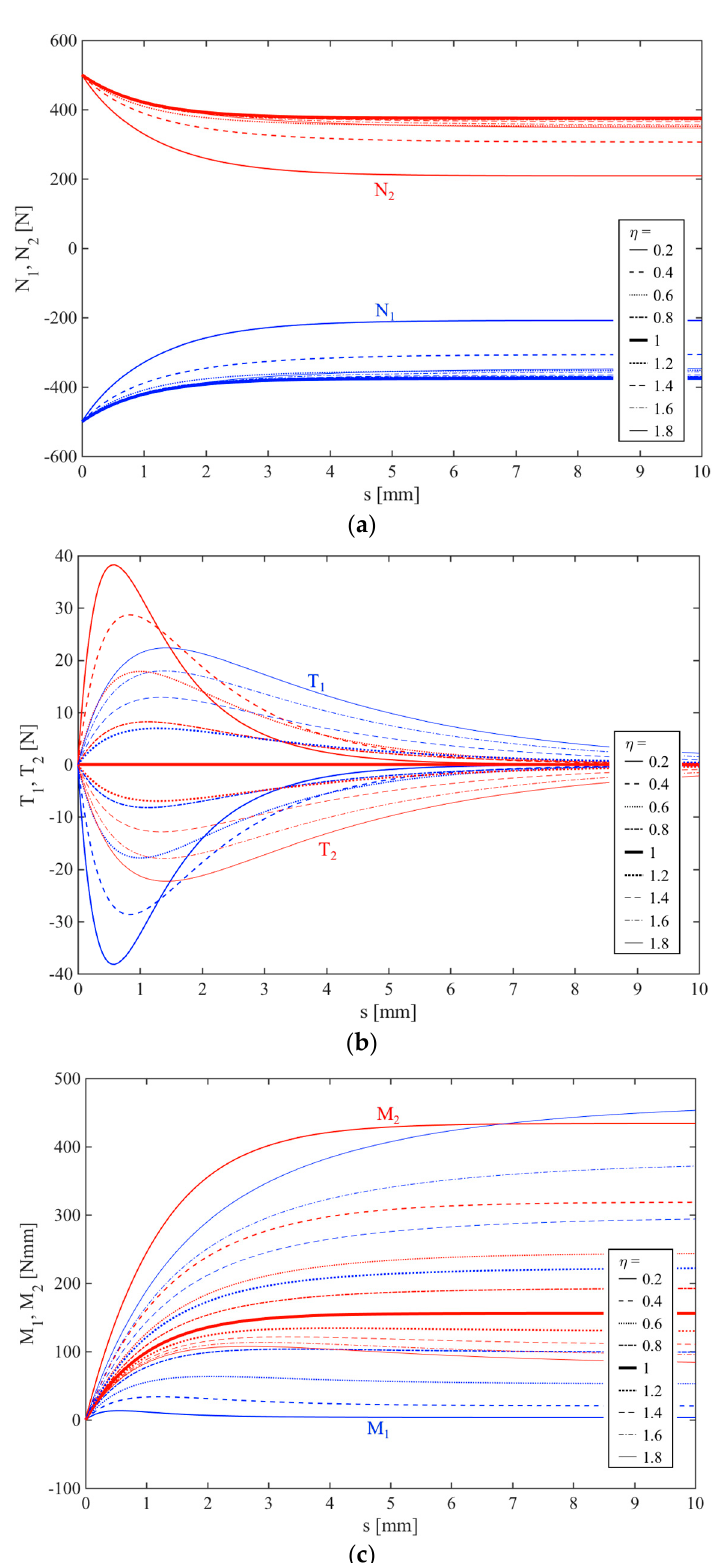
η Figure 13. Effect of the thickness ratio on the static response of the sublaminates: ( a ) Axial force; Figure 13. Effect of the thickness ratio η on the static response of the sublaminates: ( a ) Axial force; ( b ) Shear force; ( c ) Bending moment. (Isotropic specimen). ( b ) Shear force; ( c ) Bending moment. (Isotropic